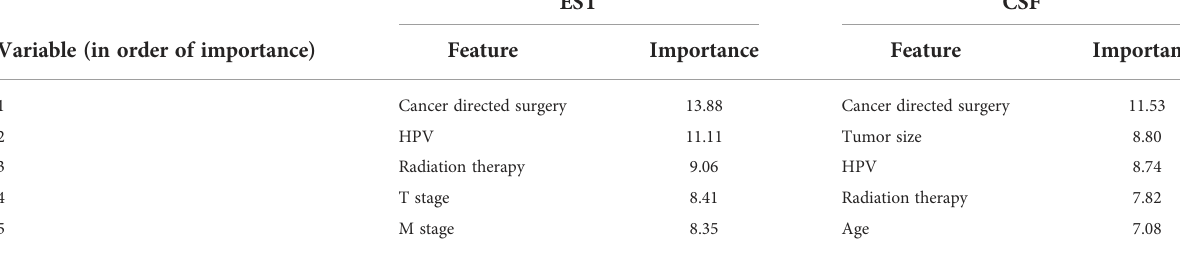
TABLE 2 Importance of various variables in each machine learning model. EST CSF Variable (in order of importance) Feature Importance Feature Importance